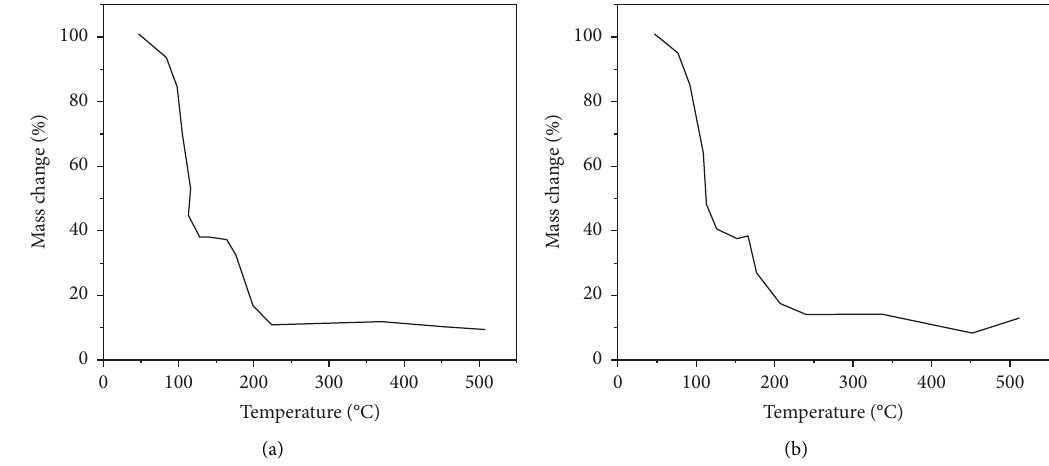
Figure 2: TG-DSC curves of zinc acetate dihydrate precursor and particle-free ZnO ink. (a) Zinc acetate dihydrate. (b) Particle-free ZnO ink.